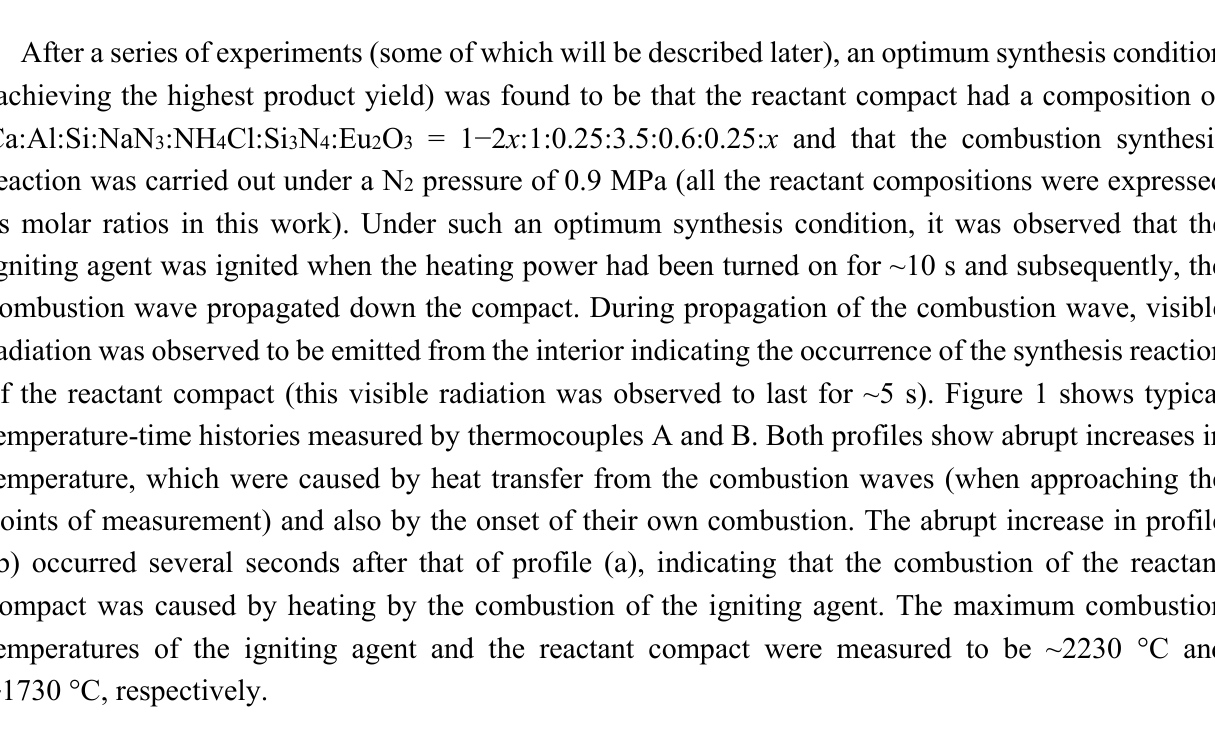
Figure 1. Typical temperature-time histories during combustion